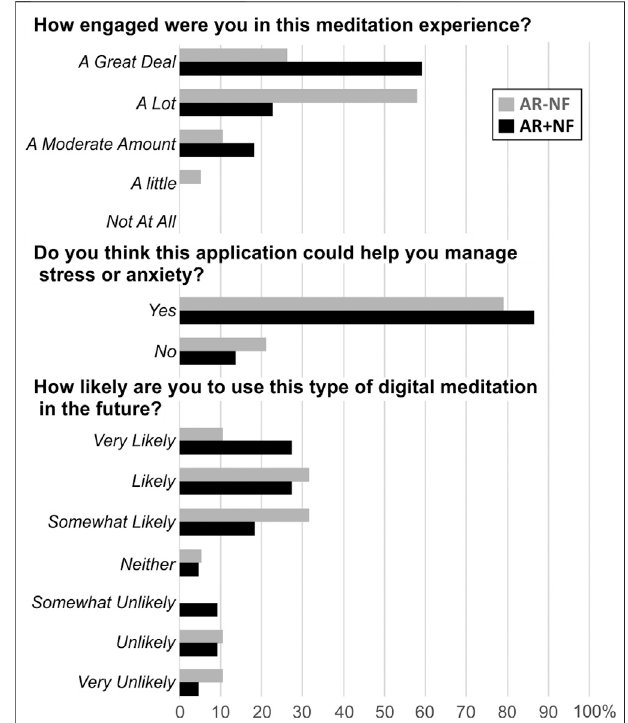
FIGURE 5 | Between-group item endorsement patterns for AR experience questions. Percentage of response endorsements for each item for each group are